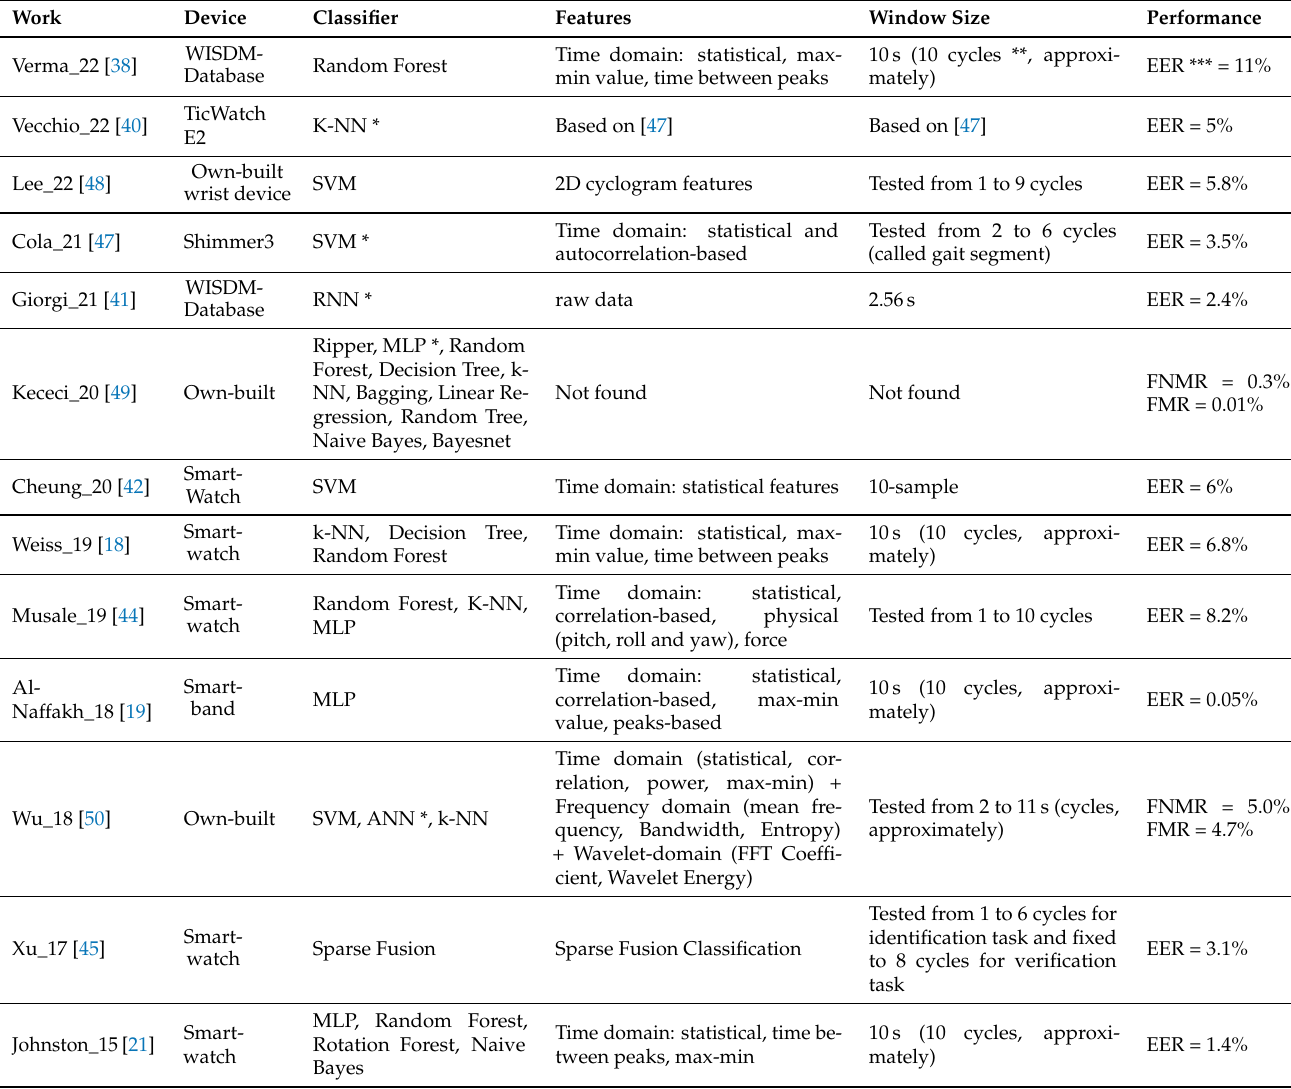
Table 1. Brief description and best results with state-of-the-art